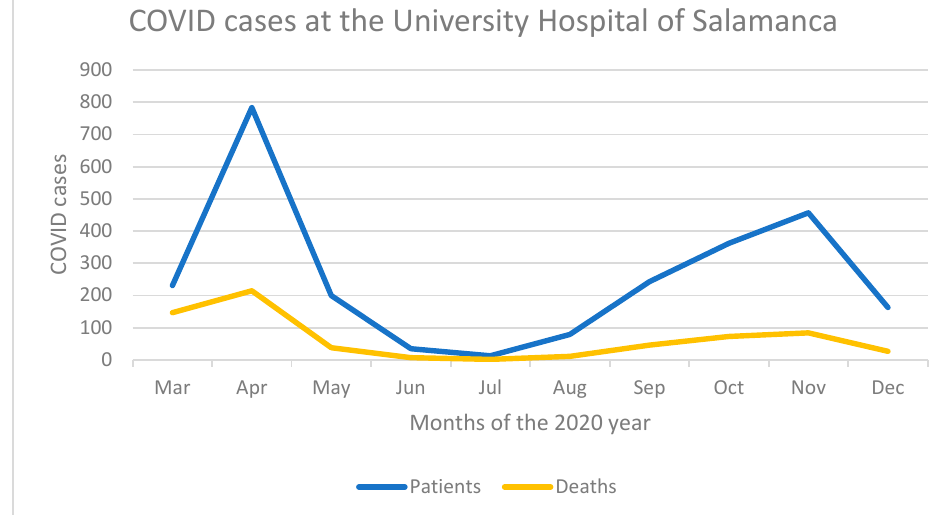
Figure 1. Evolution of COVID-19 cases at the Clinical Hospital of Salamanca for 2020.